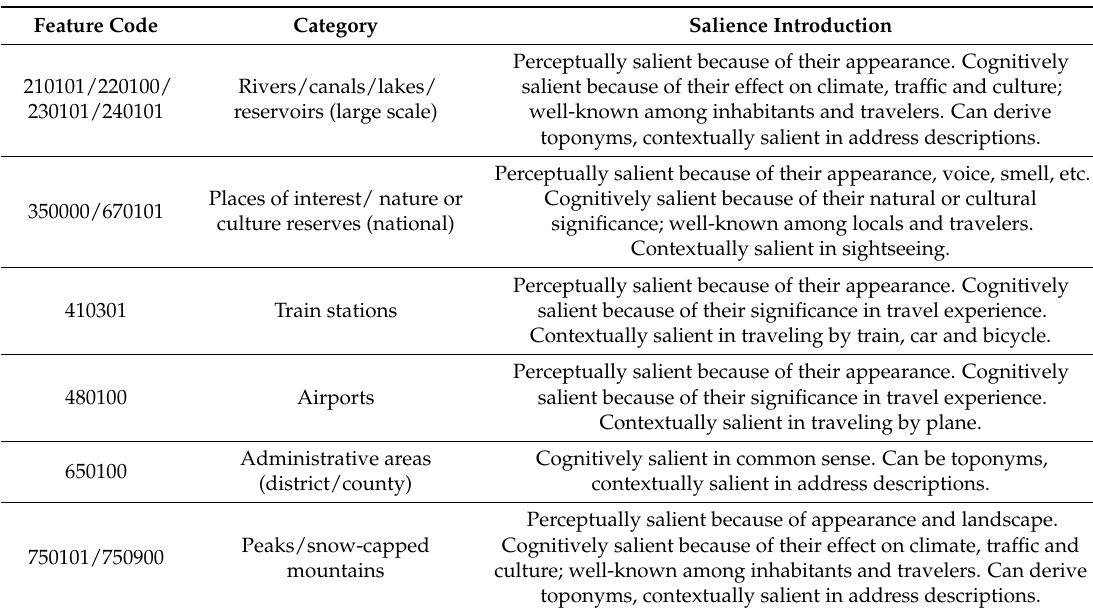
Table 1. Categories of Landmarks at Small